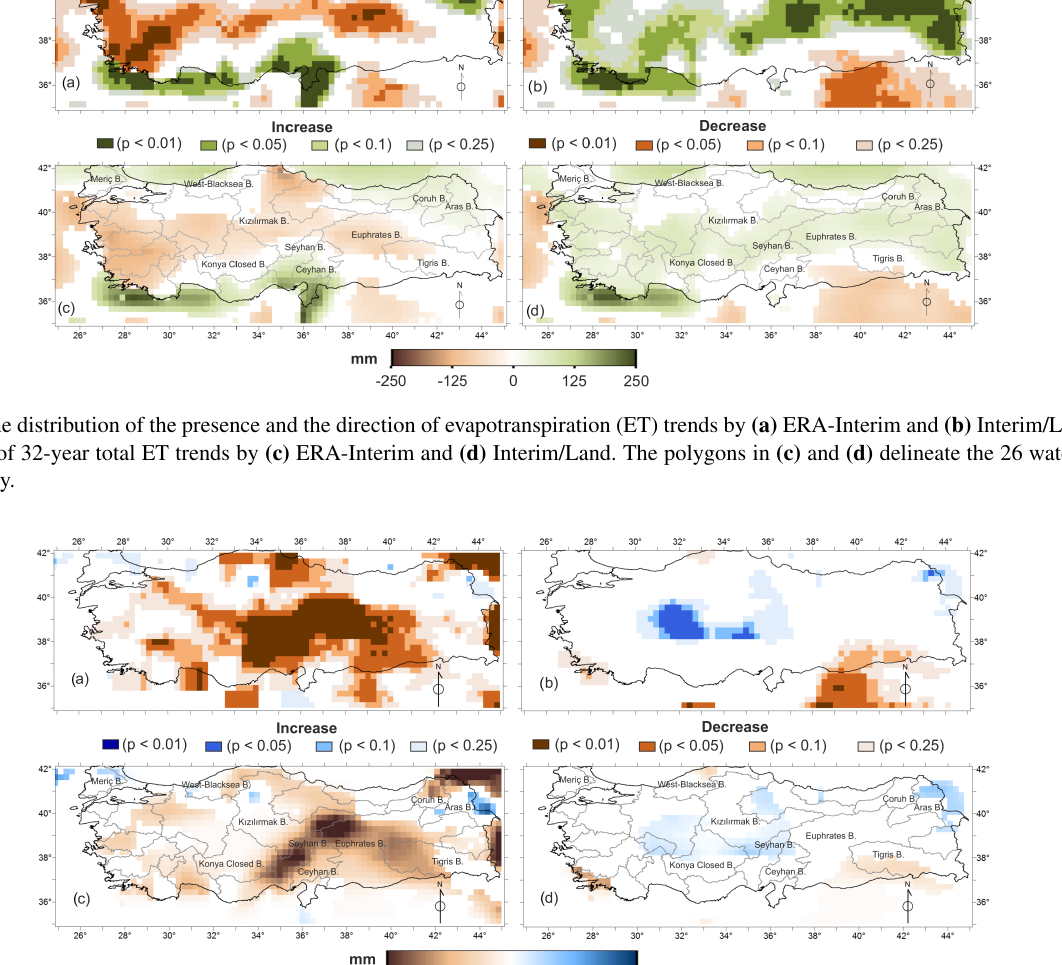
situ data can be assumed to be valid for runoff data as